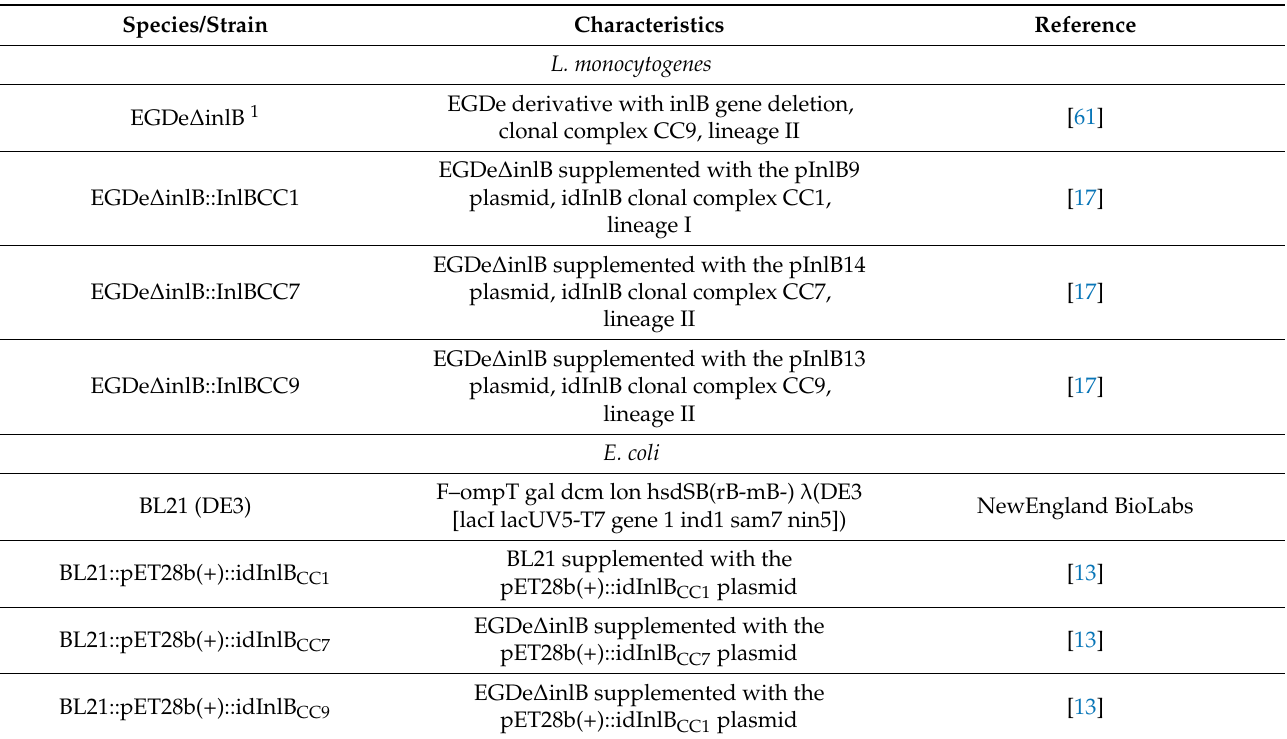
Table 1. Strains used in the